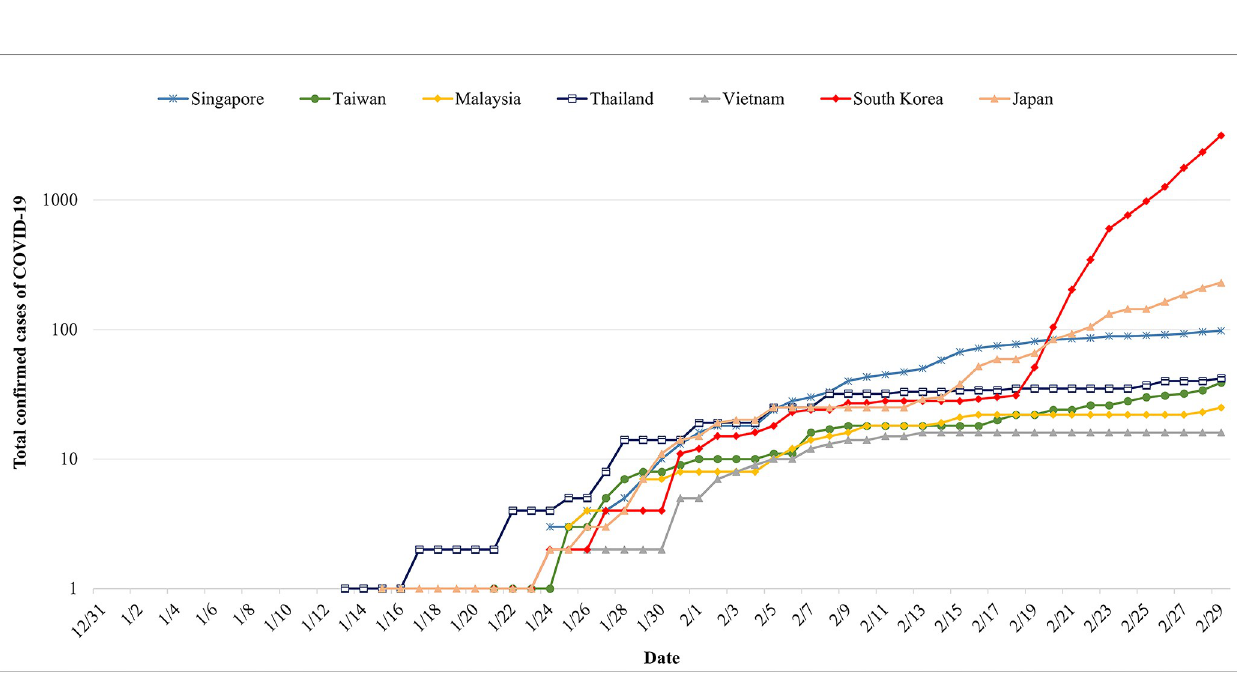
PLOS ONE | https://doi.org/10.1371/journal.pone.0251845 May 20, 2021 11 /